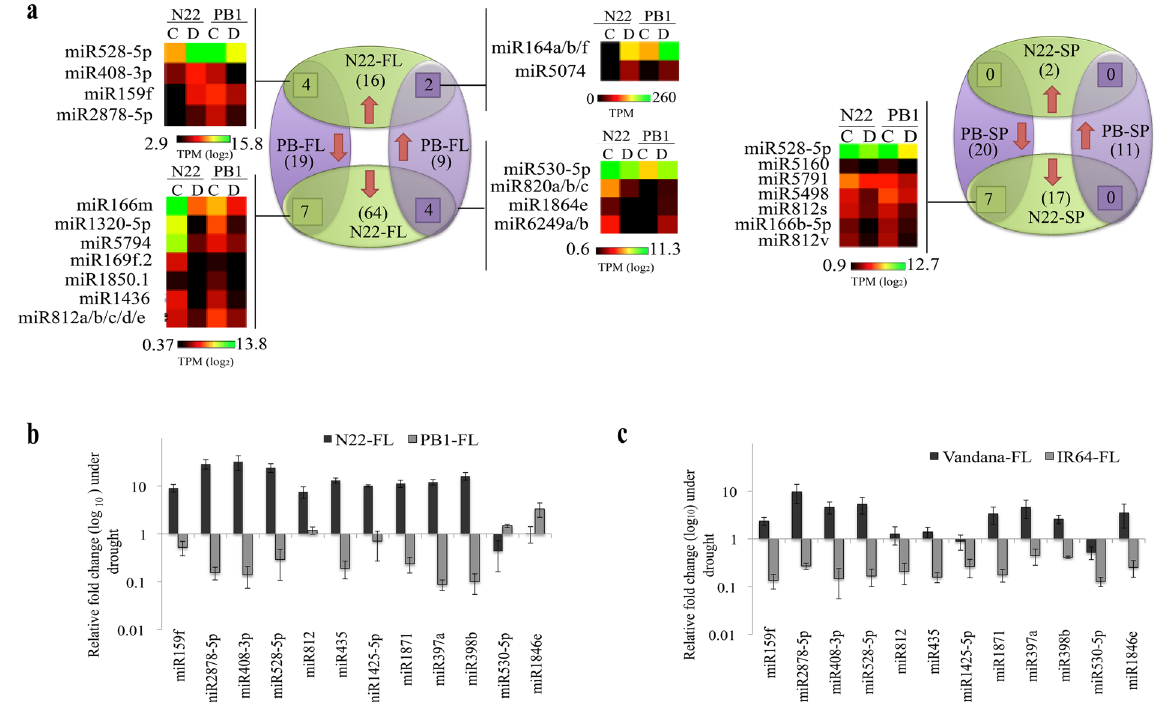
Figure 2. Identification and validation of cultivar-specific drought responsive (CSDR) miRNAs in contrasting rice cultivars. ( a ) Comparison of drought response of miRNAs between N22 and PB1 in flag leaf (FL) and spikelet (SP) in the form of venn diagrams between control (C) and drought (D) datasets. The heat maps were plotted on the log normalize the miRNA transcript levels. Bars represent the standard error. Each expression value represents the mean value of six biological replicates with three technical